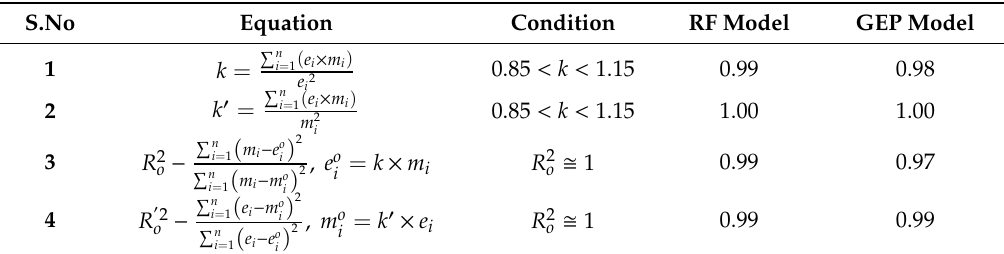
Table 9. Statistical analysis of RF and GEP models from external Table 9 . Statistical analysis of RF and GEP models from external validation .